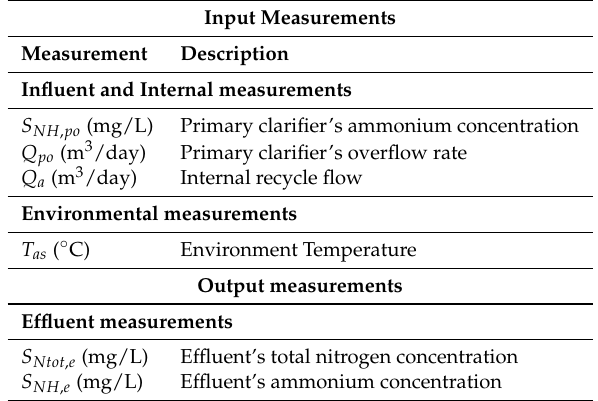
Table 2. Range, mean, and standard deviation of some WWTP